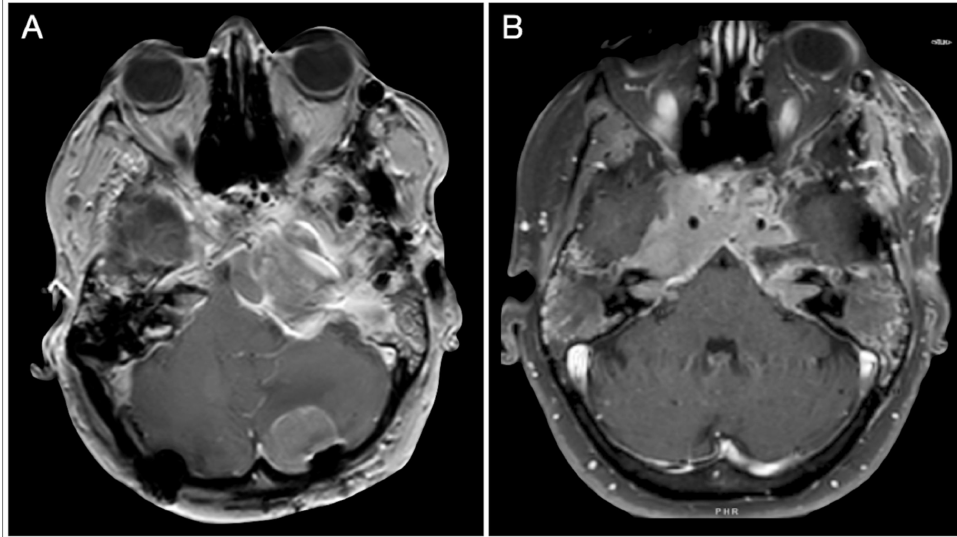
Figure 26. ( A , B ) Axial T1-weighted contrast-enhanced MRI. Scale bar: 5